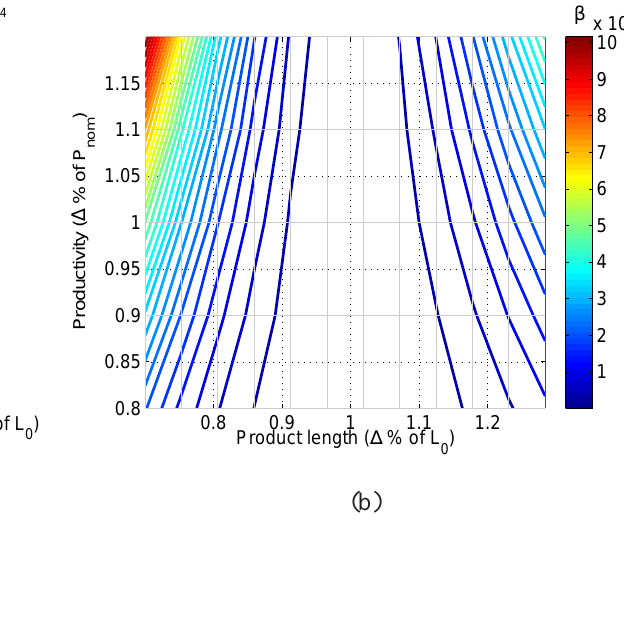
Table 1. Dimension-less r.m.s. acceleration and speed coefficients.